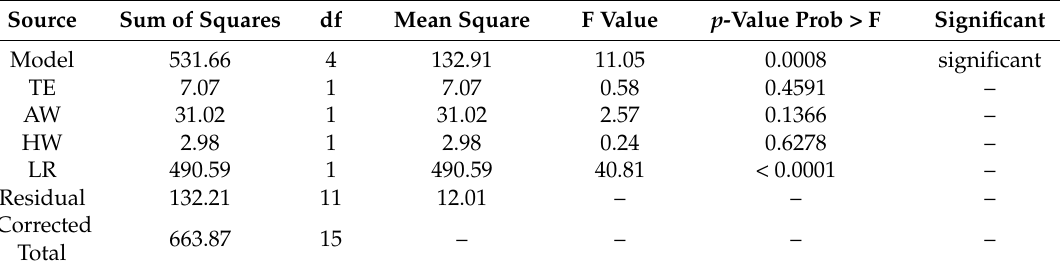
Table 1. ANOVA of MOE reduction